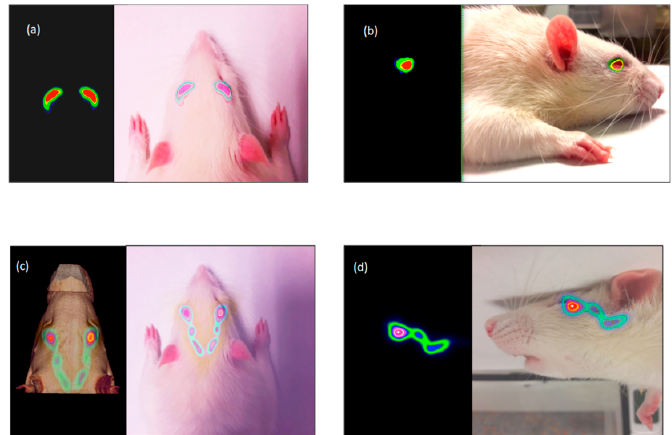
Figure 1. Fusion PET-CT-Real images of the rat's head. Tacrolimus eye drops remain on the ocular surface after instillation ( a , b ) subsequently observed as it is eliminated by the nasolacrimal ducts ( c , d ). Axial ( a ) and sagittal ( b ) PET image and fusion PET-real images (10 min). Axial ( c ) fusion PET-CT image and Sagittal ( d ) fusion PET-real images (90 min post-administration). Reproduced with permission from [32], published by Elsevier, 2018.